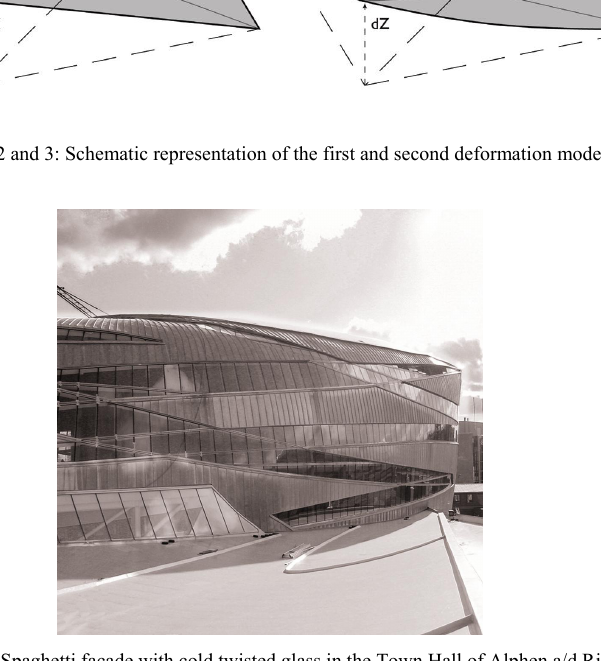
Figure 4: Spaghetti facade with cold twisted glass in the Town Hall of Alphen a/d